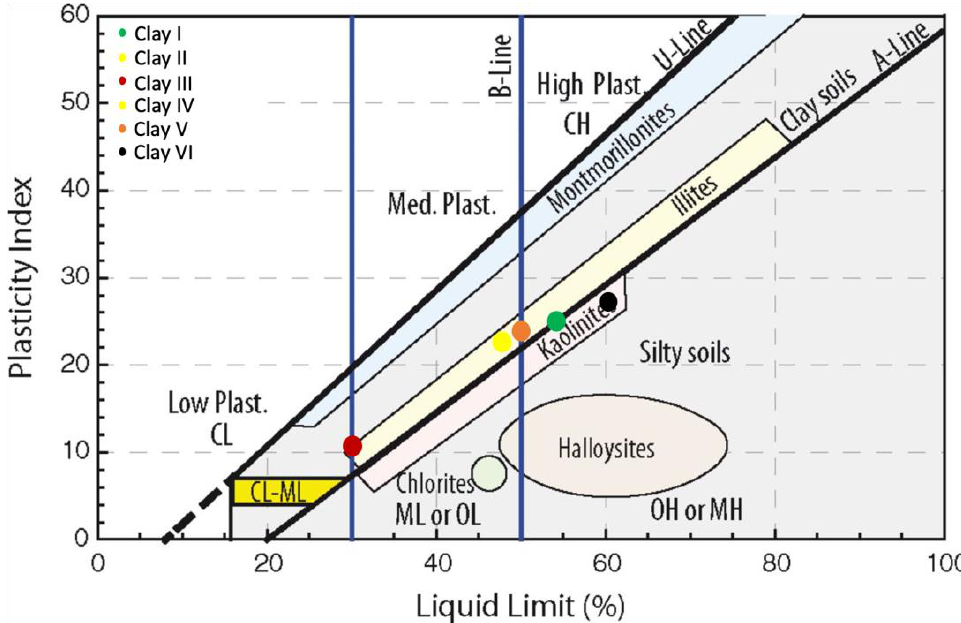
Figure 12. Location of clay studied on combined Holtz and Kovacs diagram and Casagrande plasticity chart.